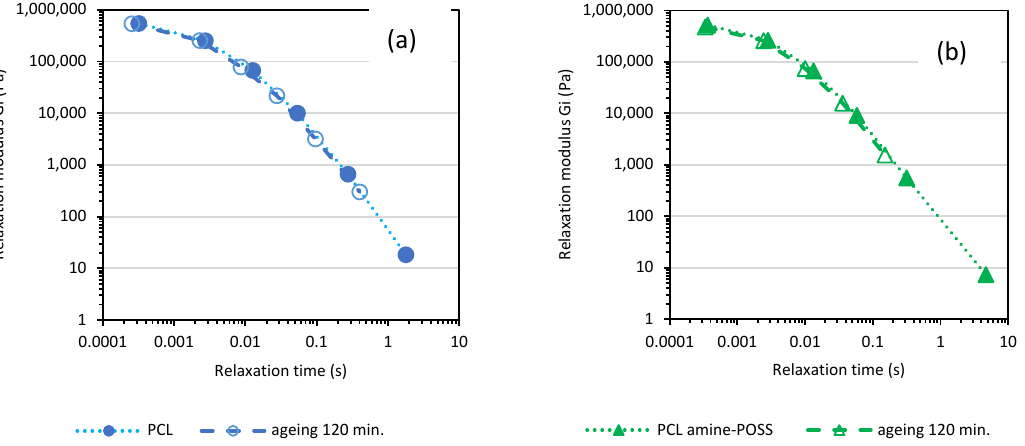
Figure 6. Calculated based on frequency sweep test discrete relaxation Maxwell’s spectra for PCL ( a ) and PCL modified by amine-POSS ( b ). Less significant changes in the values of the relaxation modulus G i and the relaxation times λ i , recalculated based on similar angular frequency range, were observed for the PCL HO-POSS and PCL Gly-POSS composites indicating that the presence of both POSS- stabilized materials during thermo-oxidative treatment as compared with neat PCL (Fig- ure 7).